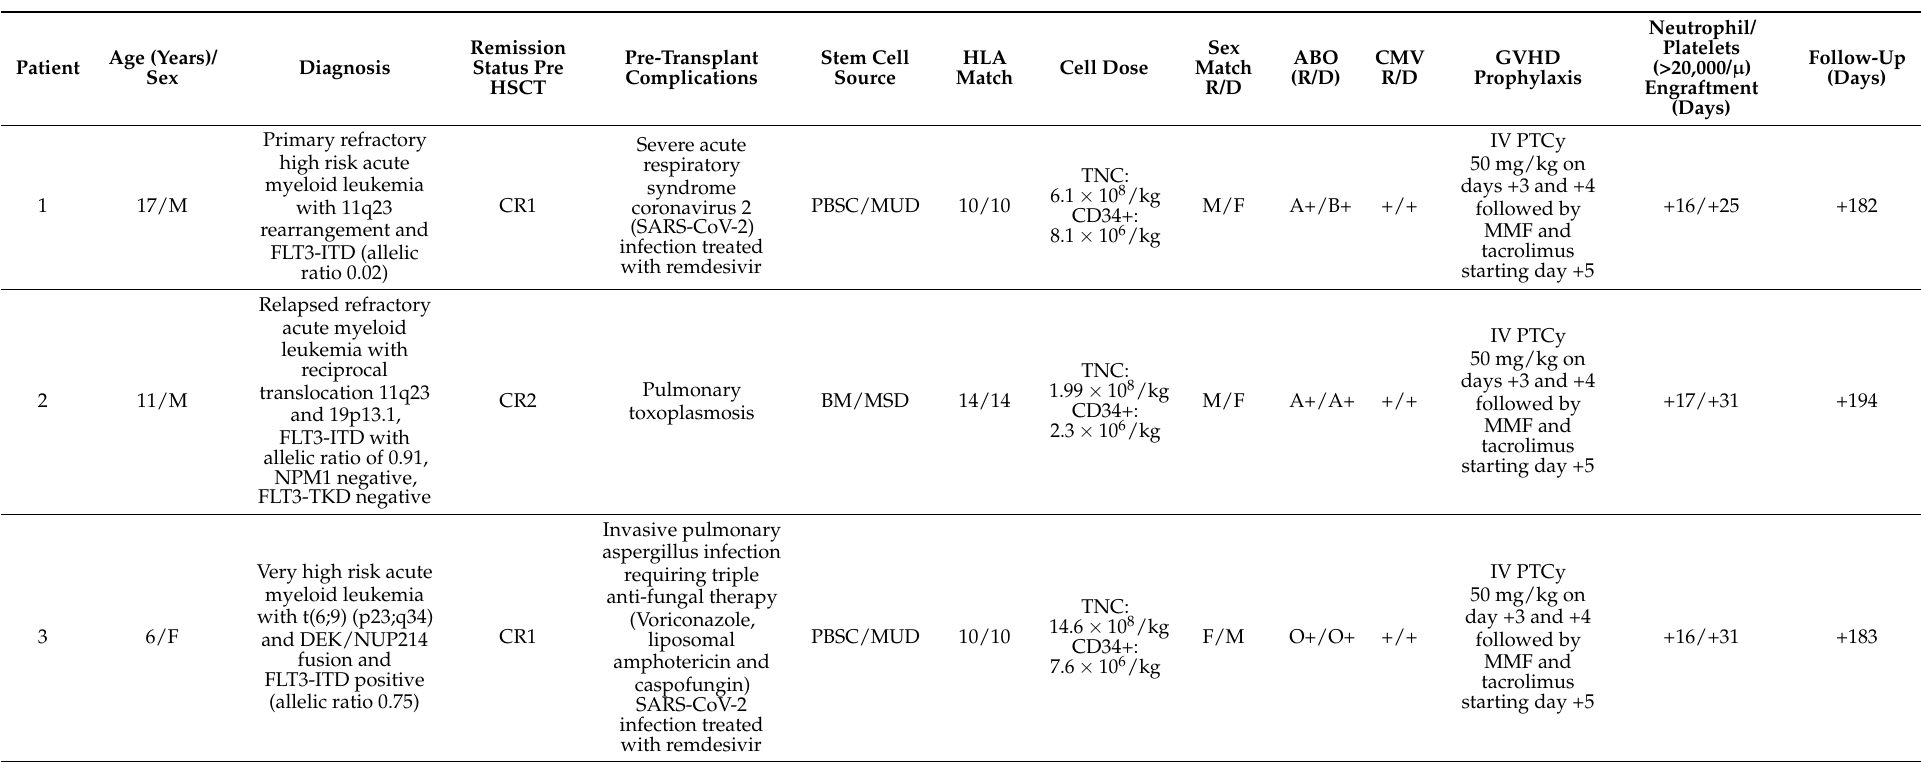
Table 1. Patients’ demographics and transplantation